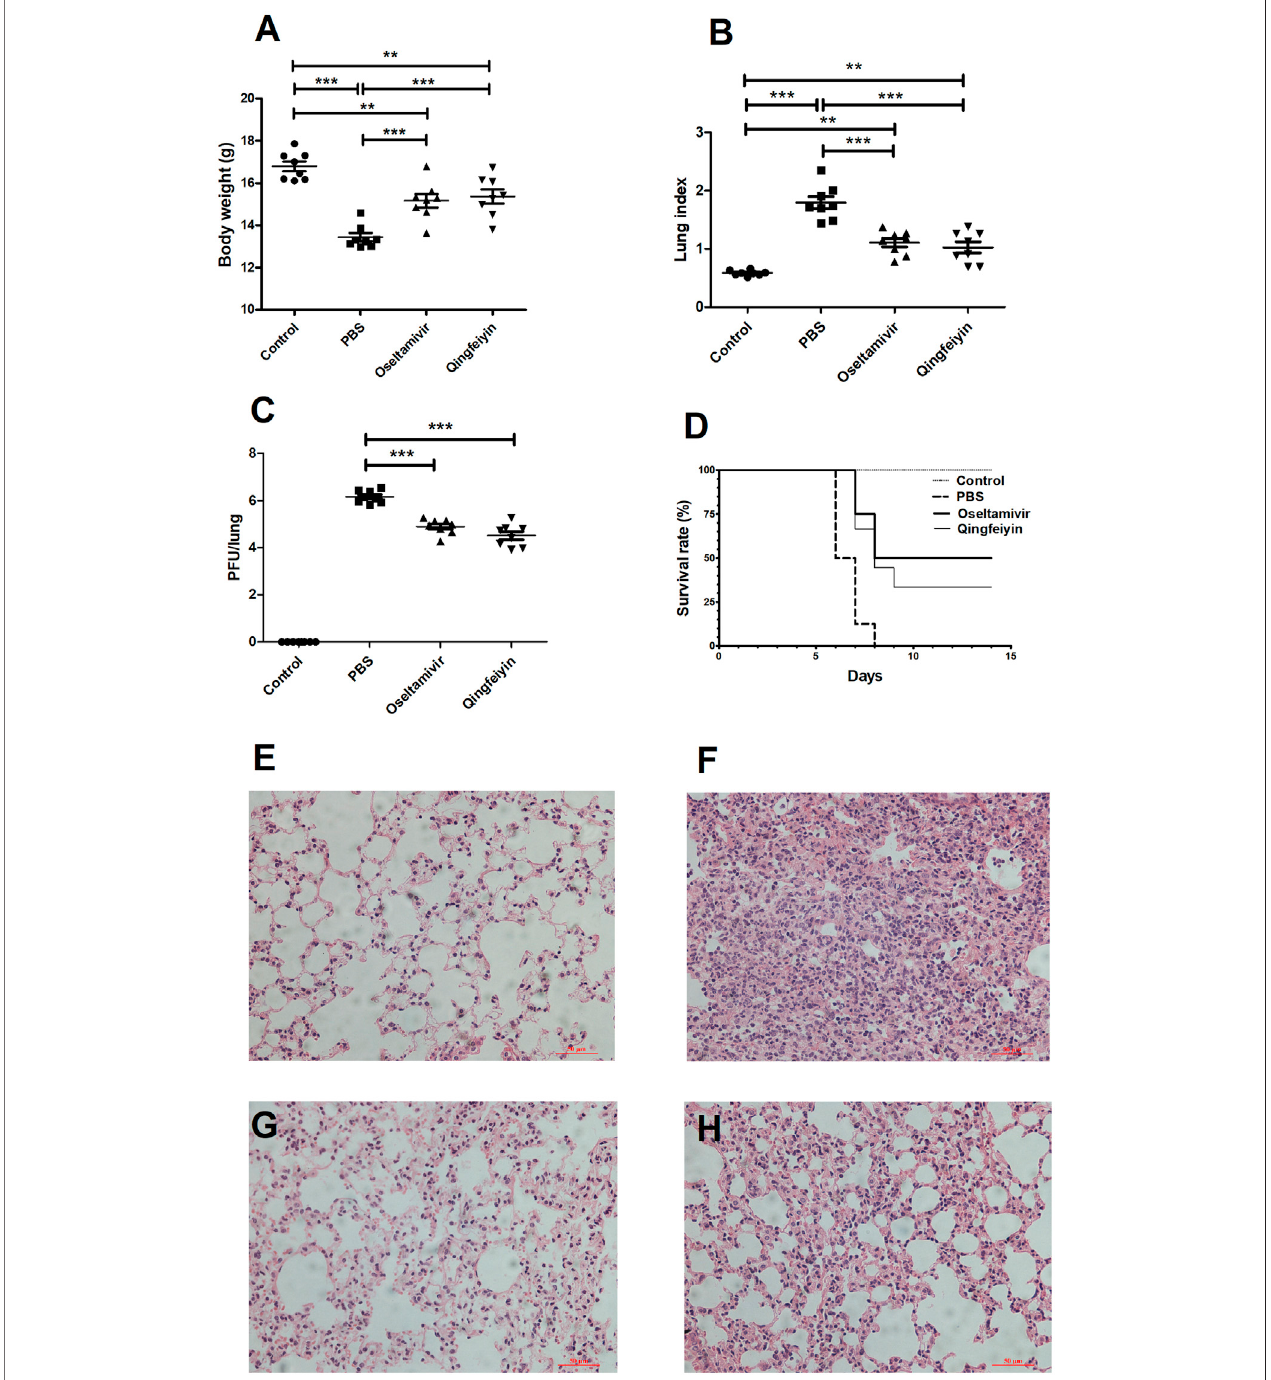
FIGURE2| TheeffectofQFYDonthecolonofmiceinfectedwiththeH1N1virus.Comparedtothecolonofnormalmice (A) ,theH1N1virusshortenedthelengthof the colon (B) , oseltamivir (C) , and QFYD (D) restored the length of the colon to a certain extent. (E) was the comparison of the colon length of four groups. (F – I) is representative H/E staining pictures of control, PBS, oseltamivir, and QFYD group (x 200), respectively. The data of colon length was analyzed by analysis of variance (ANOVA). p < 0.05 means the statistical difference. *** p < 0.001.